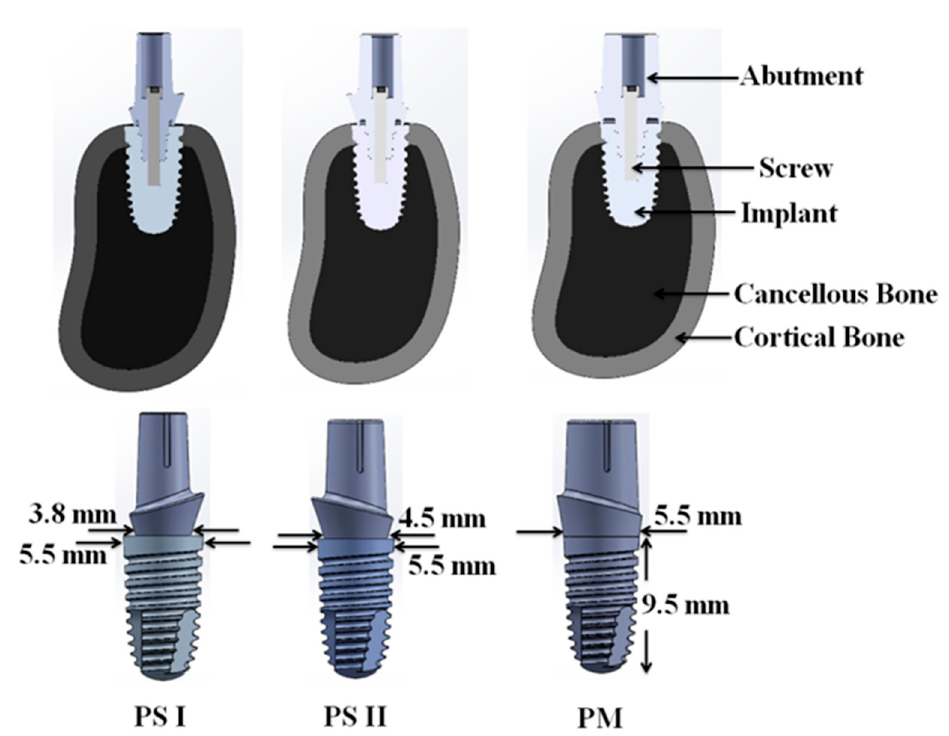
Figure 2. CAD model of assembly (abutment, screw, implant, cancellous, and cortical bone) gener- ated for PS I, PS II, and PM configuration. for PS I, PS II, and PM